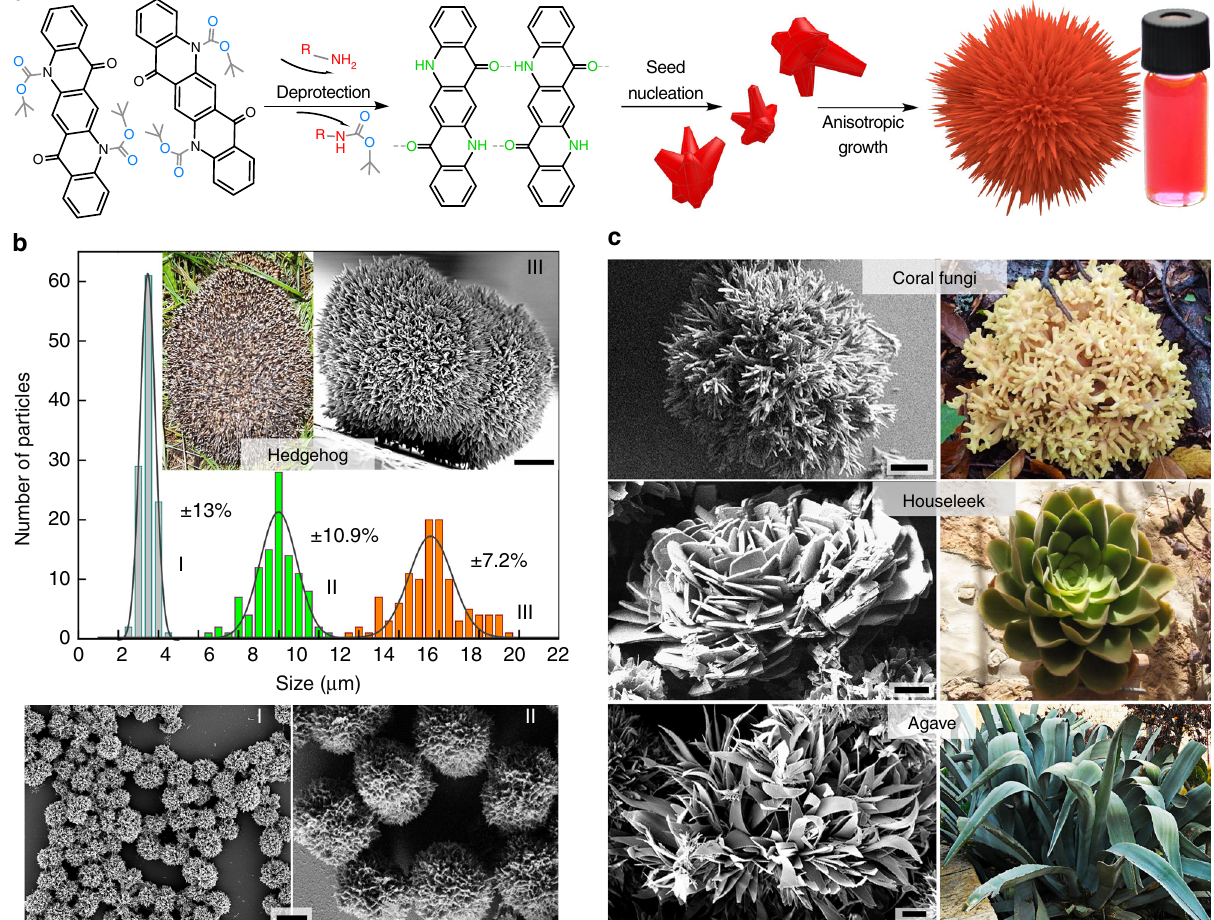
Fig. 1 Colloidal quinacridone hierarchical nanoarchitectures with bio-inspired shapes. a The synthesis proceeds when soluble N , N ′ -di( t -butoxycarbonyl) quinacridone (tBOC-QNC) is deprotected via an amine migration reaction, giving monomeric quinacridone (QNC) molecules that crystallise via an interplay of H-bonding and π – π stacking. These ligand-covered colloidal nanocrystals then assemble due to van der Waals forces into hierarchical colloidal assemblies. b The size of hedgehog crystals is determined by the starting concentration of tBOC-QNC, allowing narrow size distribution to be achieved. Three sizes — I, II and III are shown in the SEM micrographs. c Nanoarchitectures with shapes of various plants, given on the photos, are obtained by using different ligands. Scale bars on the electron micrographs = 4 μ